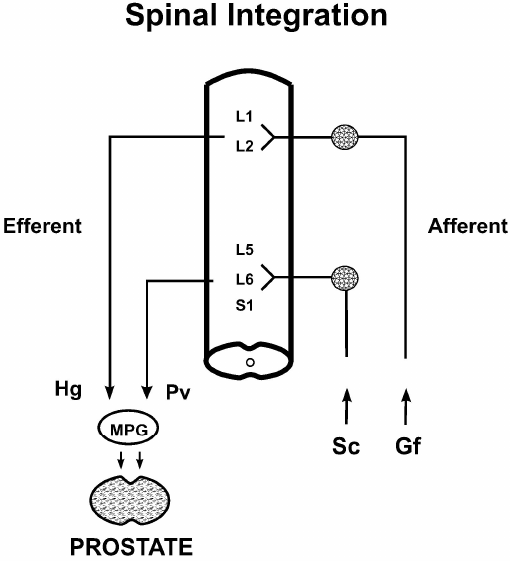
Fig. 5 – The nervous control of the prostate. Model indicating that the prostate gland is being regulated by a spinal circuit integrating somatic afferents from the scrotal (Sc) and genitofemoral nerves (Gf). These nervesprojectrespectivelytolumbar(L)andsacral(S)spinalsegments toactivateautonomicefferents,viathepelvic(Pv)andhypogastric(Hg) nerves. The efferent nerves arrive to the major pelvic ganglion (MPG), which in turn supplies the prostate